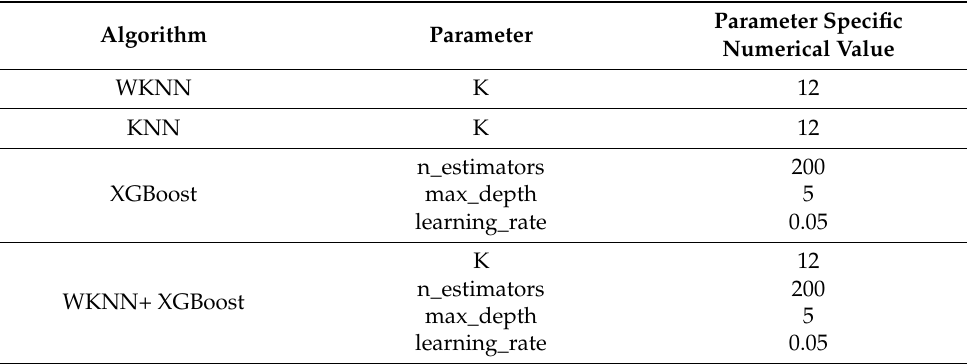
Table 2. Parameter settings of the